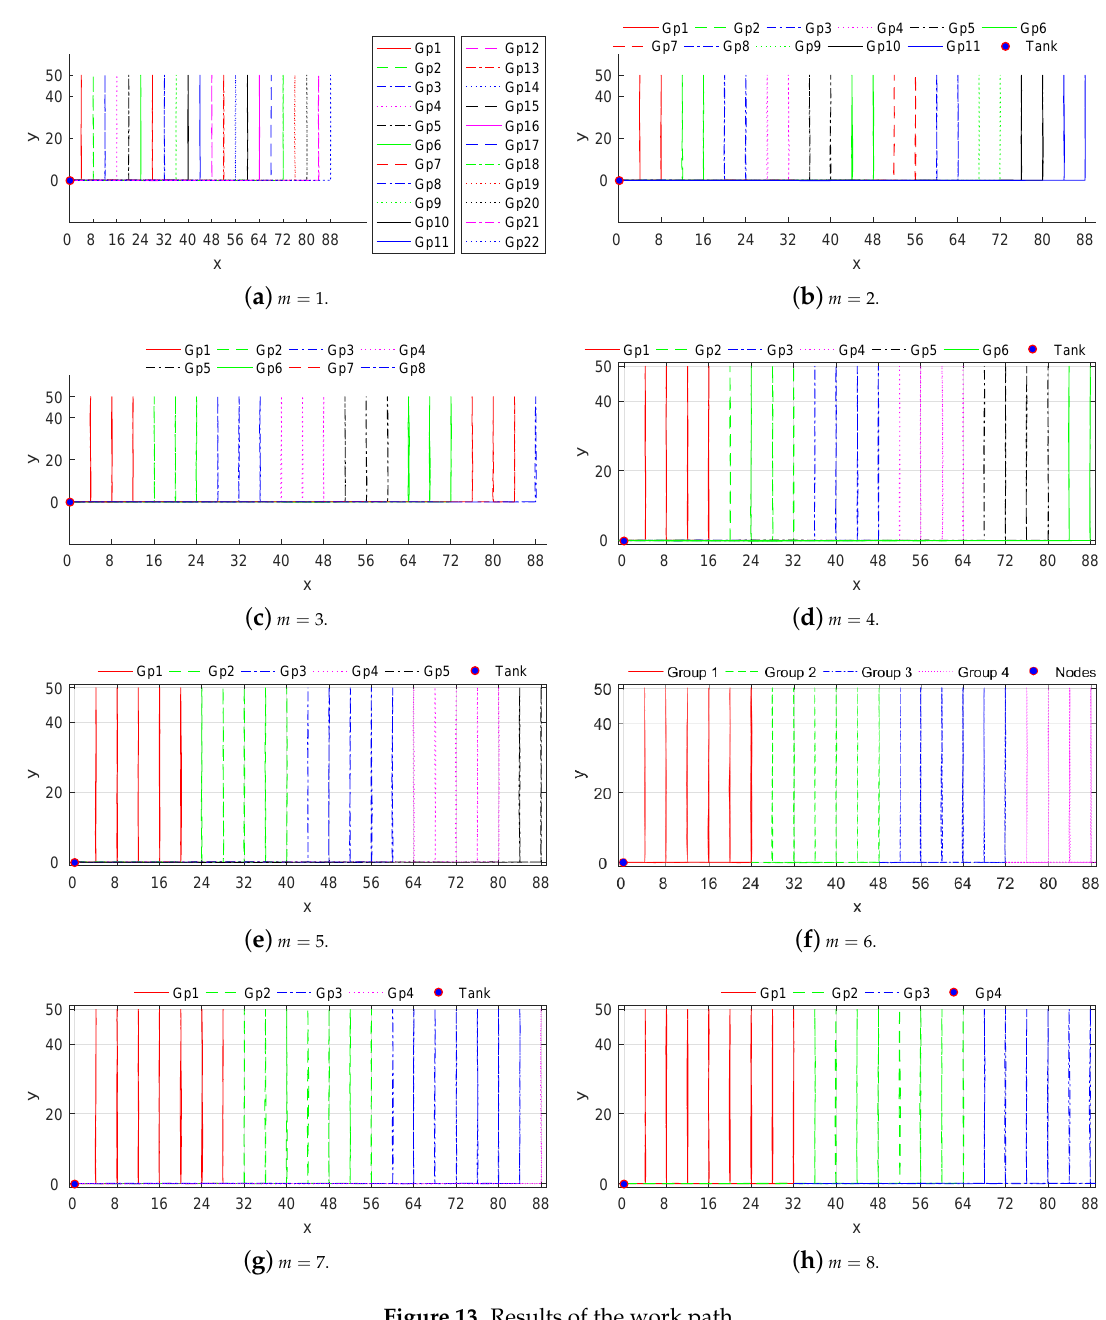
Figure 13. Results of the work